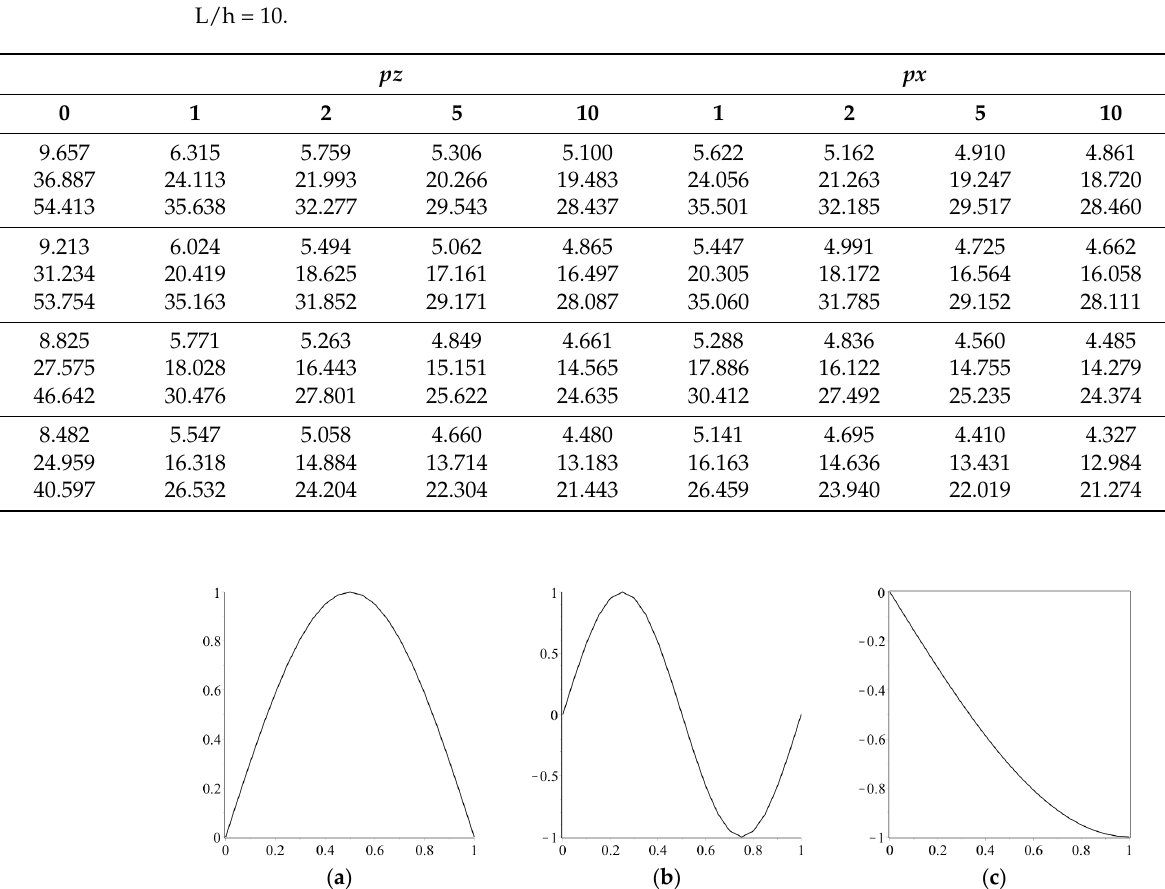
Table 5. Nondimensional first three natural frequencies ( Ω adim ) of SS FGM1-Z and FGM1-X beams.